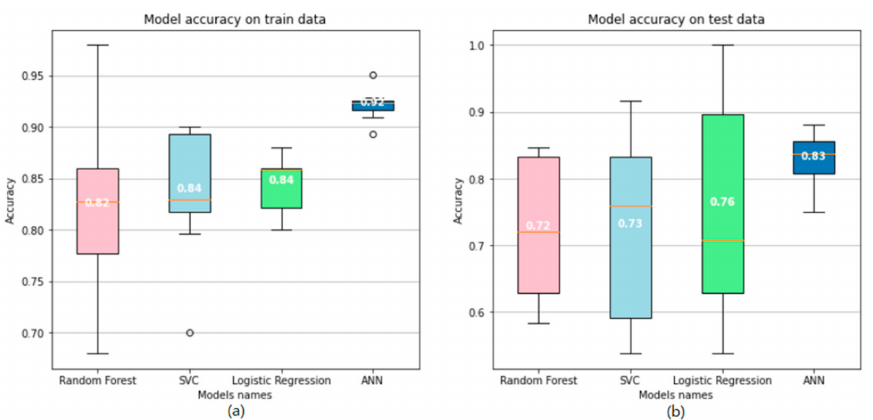
Figure 3. Accuracy of models on the original dataset. ( a ) demonstrates the accuracy of the models on train data and ( b ) demonstrates the accuracy of the models on test data.